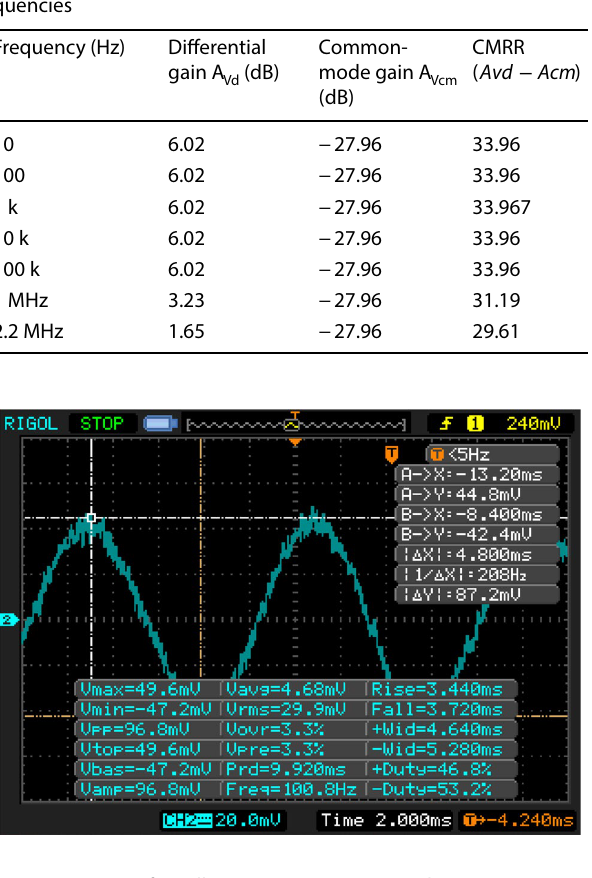
Fig. 15 Excerpt of oscilloscope measurements showing cursors A and B used for slew rate measurement